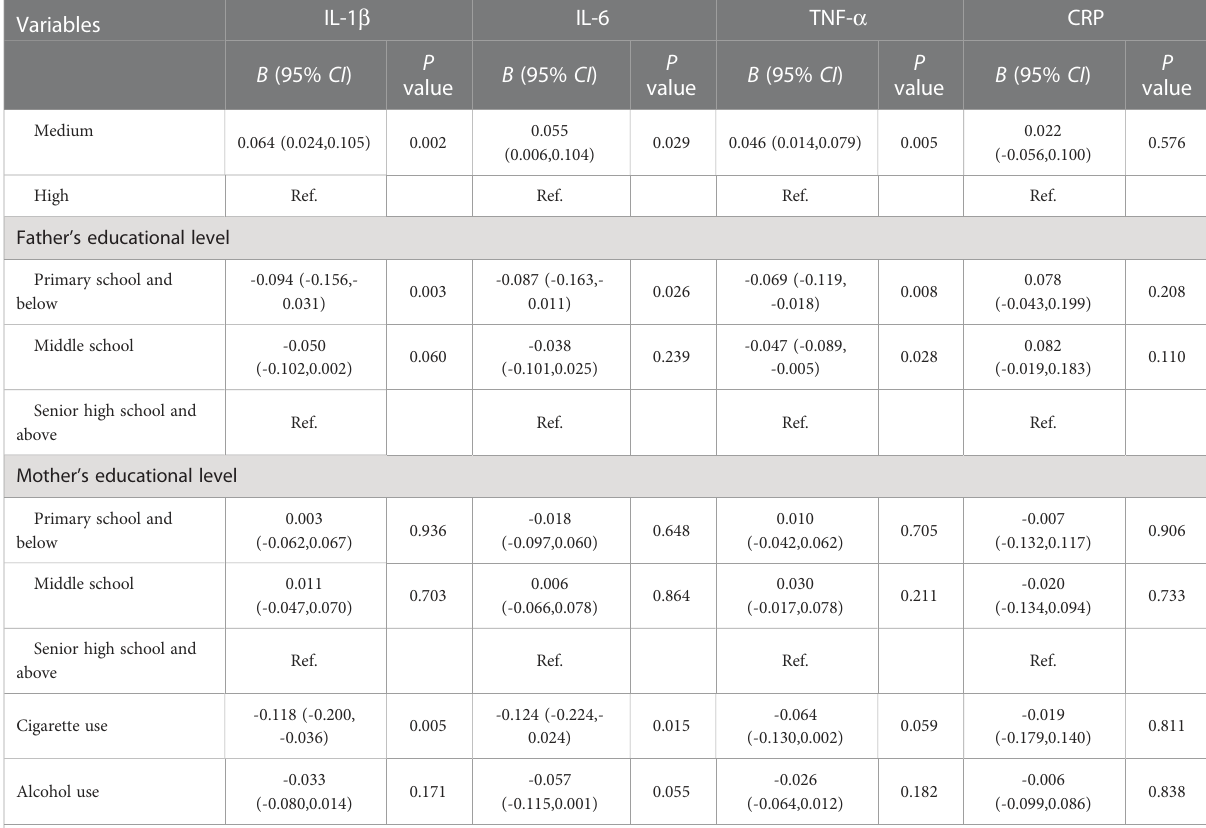
Ref. Ref. Ref. Ref.